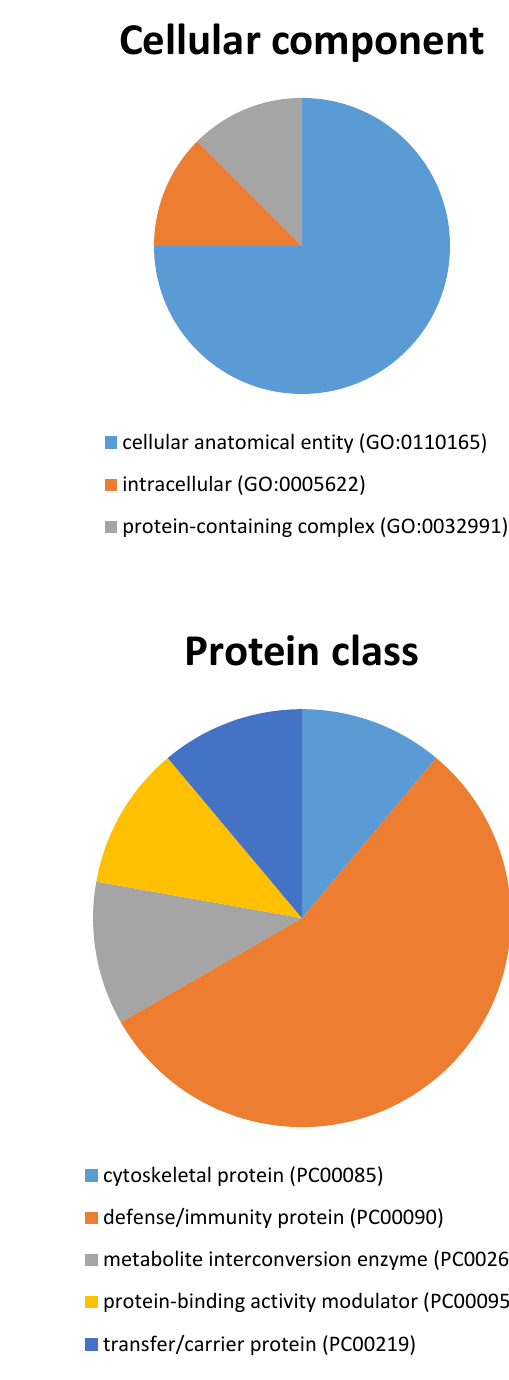
Figure 3. Pie charts showing the molecular function, cellular component, biological process, and protein class between BMS and healthy control groups based on the PANTHER classification system (http://www.pantherdb.org, accessed on 1 June